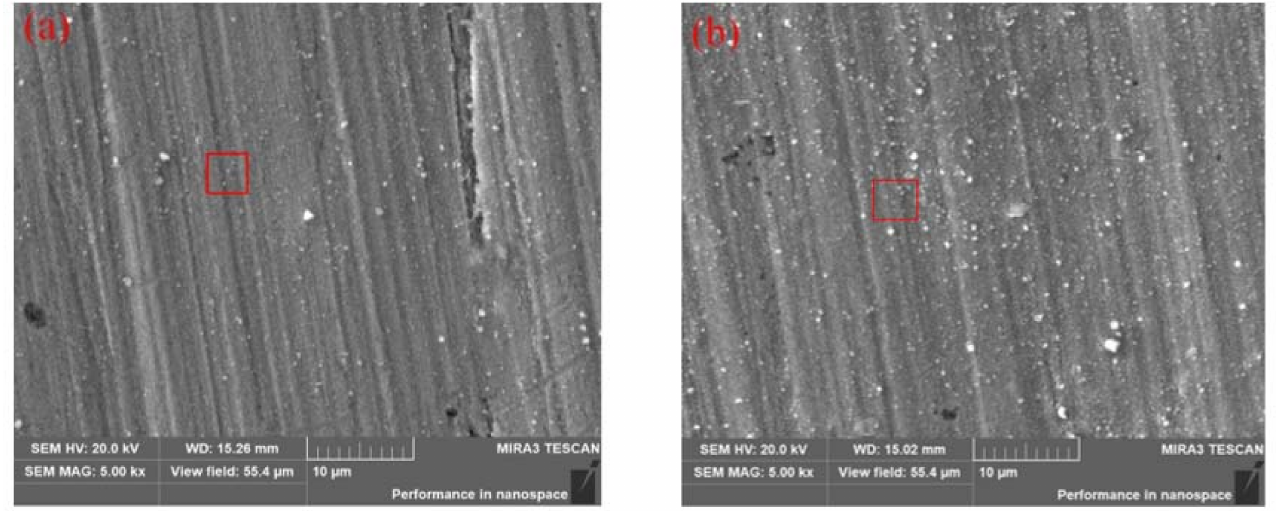
Figure 3. Surface morphologies of the fouling layer at different positions of the SG tube observed by SEM with a low magnification after 500 h of immersion at 290 ◦ C. The magnified image of the rectangular area is shown in Figure 4; ( a ) position 1, ( b ) position